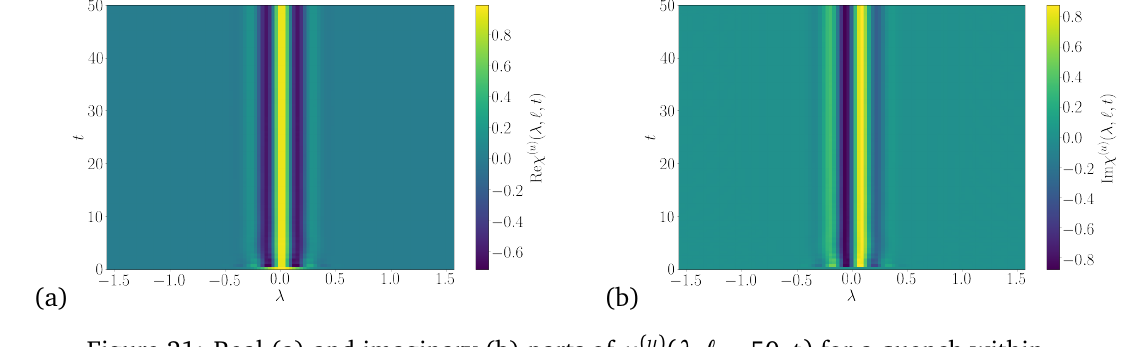
Figure 21: Real (a) and imaginary (b) parts of χ ( u ) ( λ , (cid:96) = 50, t ) for a quench within = 0.2 to h = 0.8. The dominant contribution to the the ferromagnetic phase from h 0 probability distribution arises from the small- λ